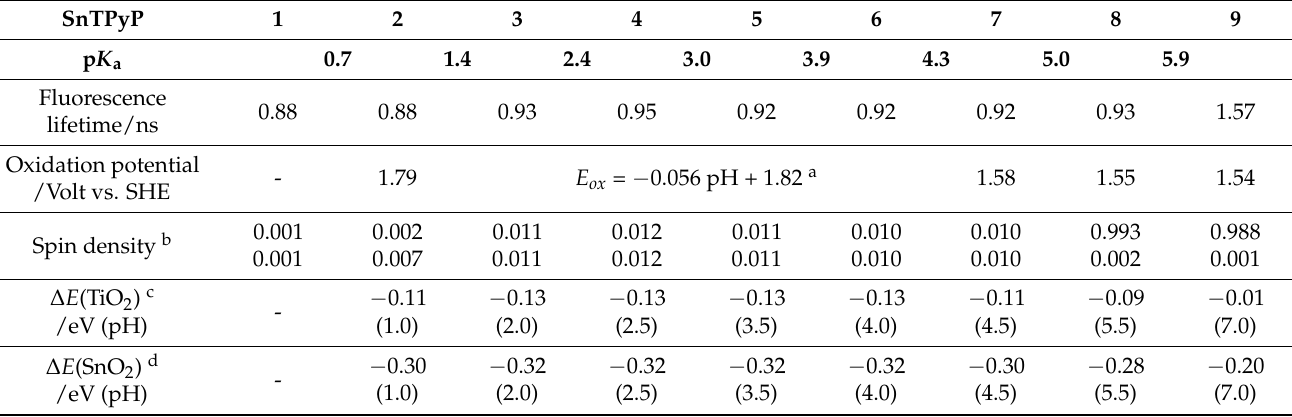
Table 1. Summary of the molecular characteristics of SnTPyP as crucial data in designing